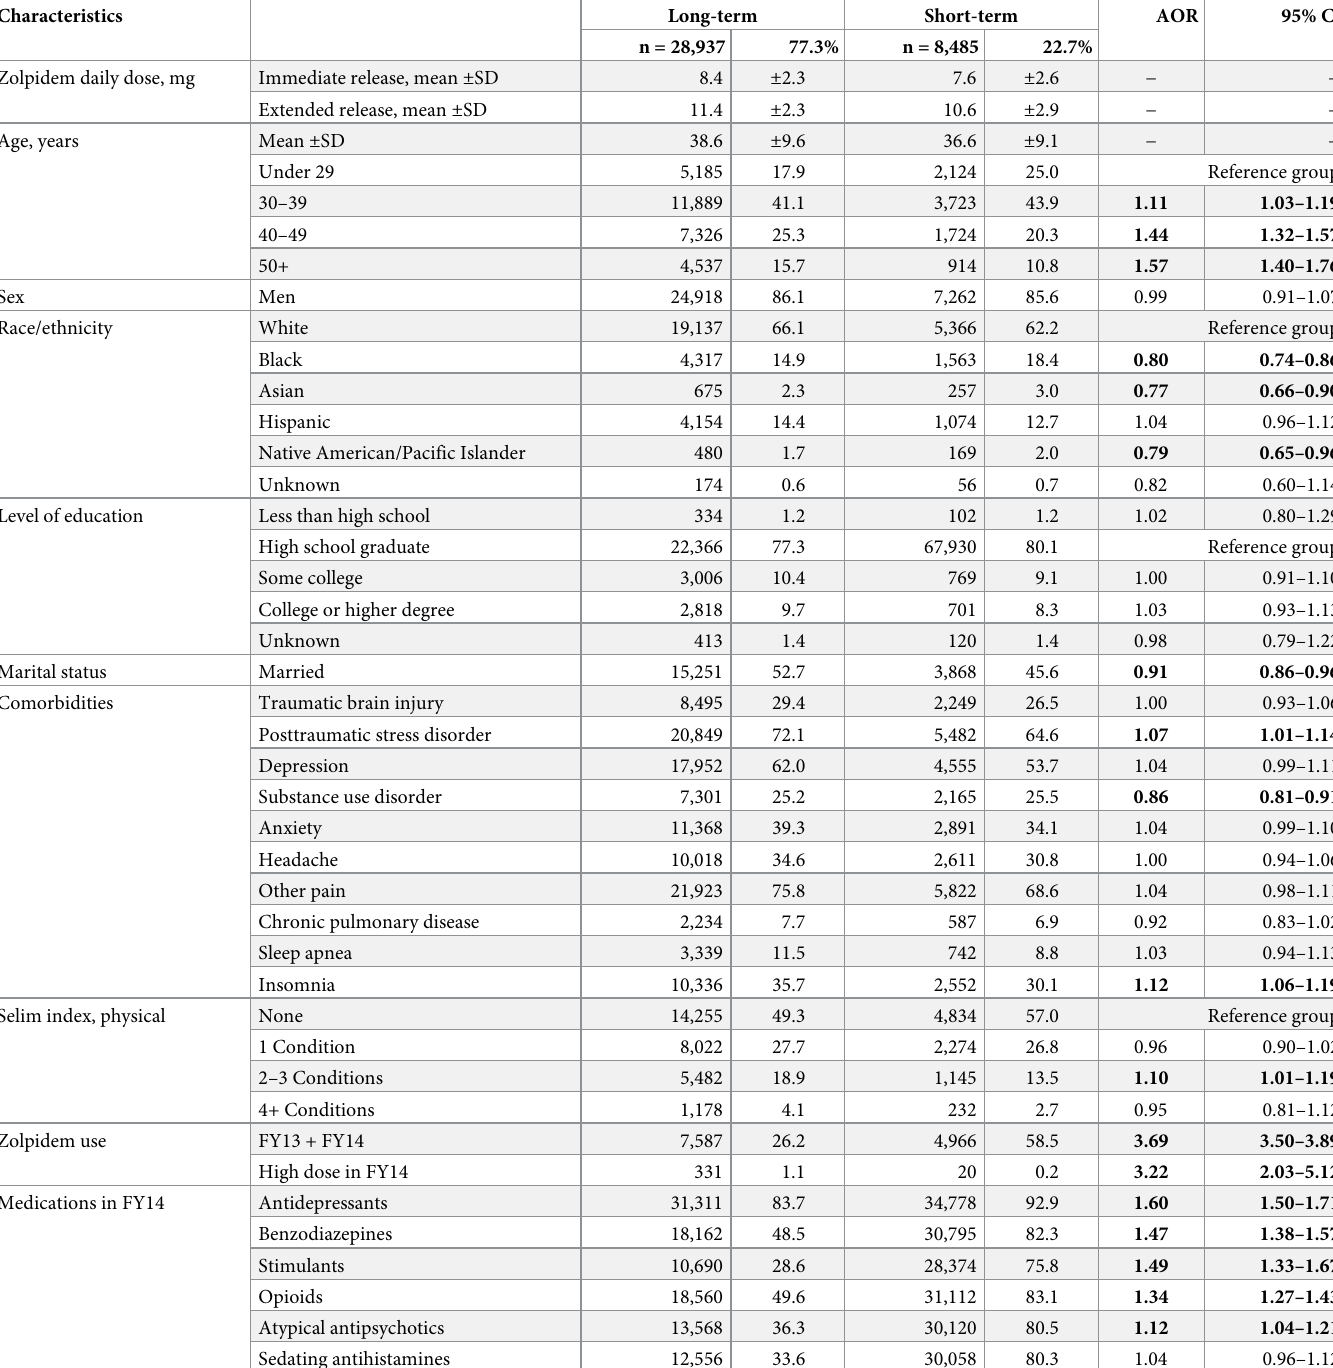
Table 2. Adjusted odds ratios (AOR) of correlates of long-term zolpidem use among Iraq and Afghanistan veterans in fiscal year 2014.